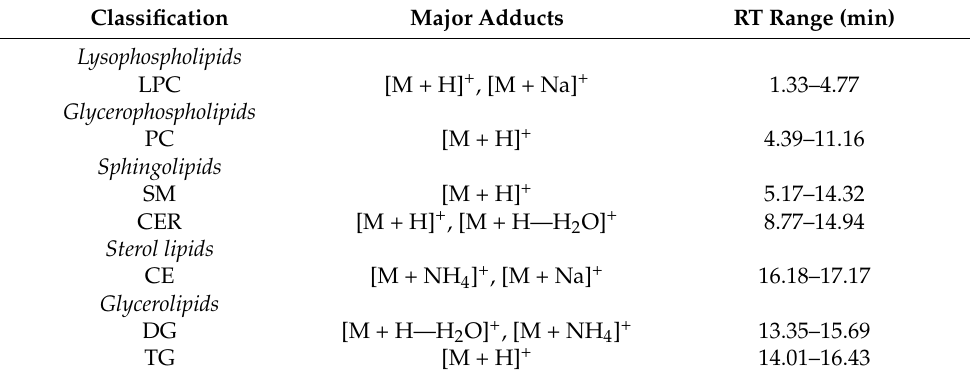
The plasma lipids classification for C57BL/6 and apoE − / − mice. Abbreviations: RT: retention time; LPC: lysophos- phatidylcholine; PC: phosphatidylcholine; SM: sphingomyelin; CER: ceramide; CE: cholesteryl ester; DG: diglyc- eride; TG: triglyceride.